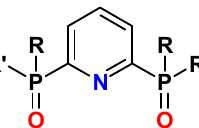
Figure 14. P,P,P (cid:48) ,P (cid:48) -tetraphenylpyridine-2,6-diphosphine oxide PyDPO Figure 14. P,P,P′,P′-tetraphenylpyridine-2,6-diphosphine oxide PyDPO . Figure 14. P,P,P′,P′-tetraphenylpyridine-2,6-diphosphine oxide PyDPO .